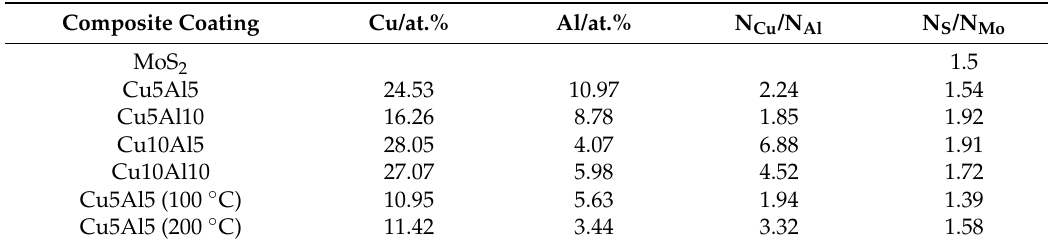
Table 3. Quantitative results of Cu-Al/MoS 2 composite coatings elemental analysis, determined through